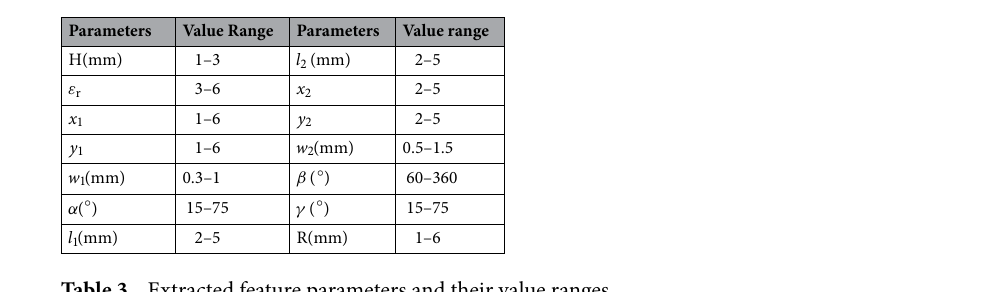
Table 3. Extracted feature parameters and their value